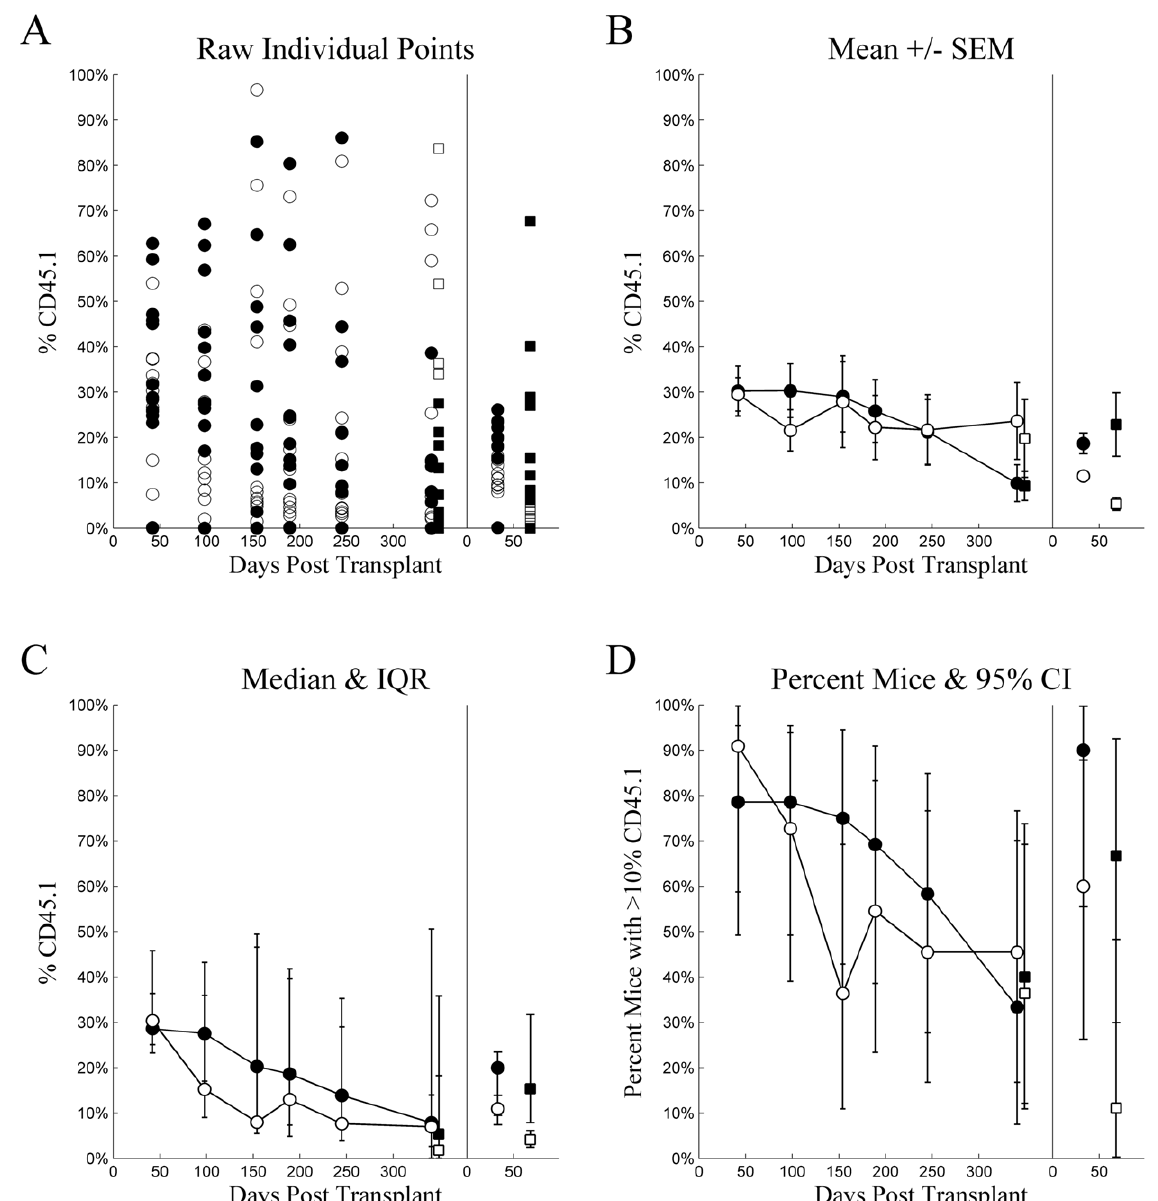
N N Figure 4. Experiment 2: intravenous injection. Chimerism (%CD45.1) (ordinate) plotted as a function of Days Post Transplant (abscissa), type of & : LT-HSC, #% : ST-HSC), and source ( # : whole blood, &% : whole bone marrow) for several different methods of summary: A) cells injected ( raw individual mouse percent CD45 cells that were CD45.1, B) mean 6 standard error of the mean, C) median with inter-quartile range, and D) percent of mice with greater than 10% of CD45 cells being CD45.1. For each tile, the data from the primary transplant is plotted on the left and secondary transplant on the right, separated by a vertical line at zero for the secondary transplant.